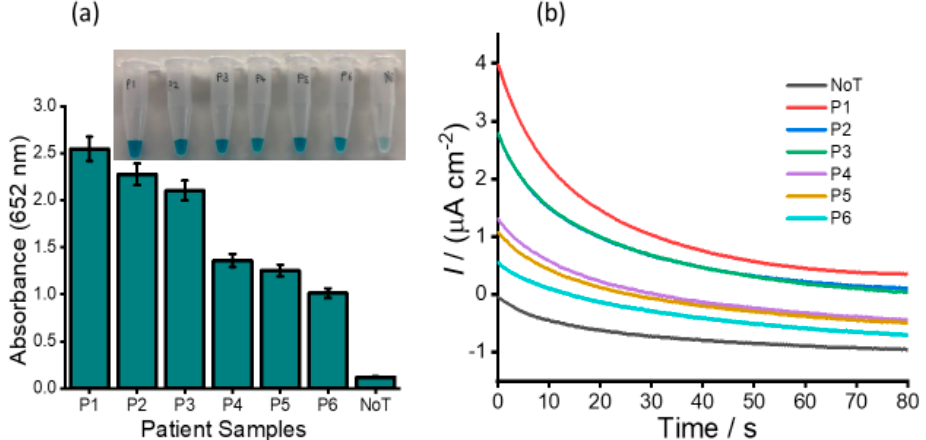
Figure 8. Analysis of human serum patient samples. ( a ) Bar diagram representing the absorbance for six serum samples collected from six ovarian cancer patients (P1, P2, P3 = high-grade serous subtypes and P4, P5, P6 = benign). (Inset: picture of the naked-eye screening); ( b ) Corresponding amperometric responses for RNA extracted from these six samples. For comparison, no template control (NoT) data are used. Error bars represent the standard deviation of three repeated experiments.